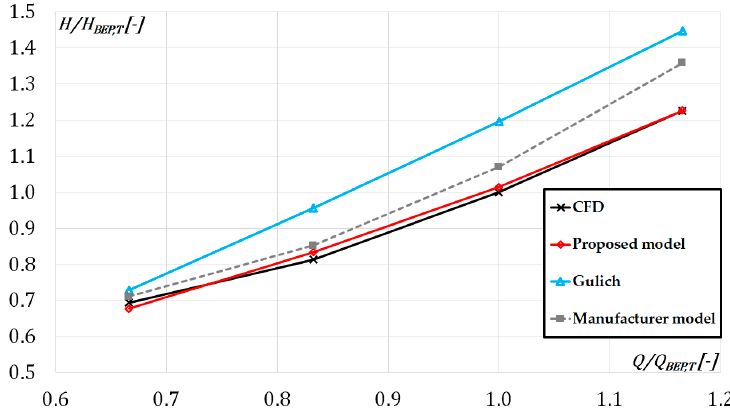
Figure 25. Comparison of different prediction models for the PaT characteristic curve.